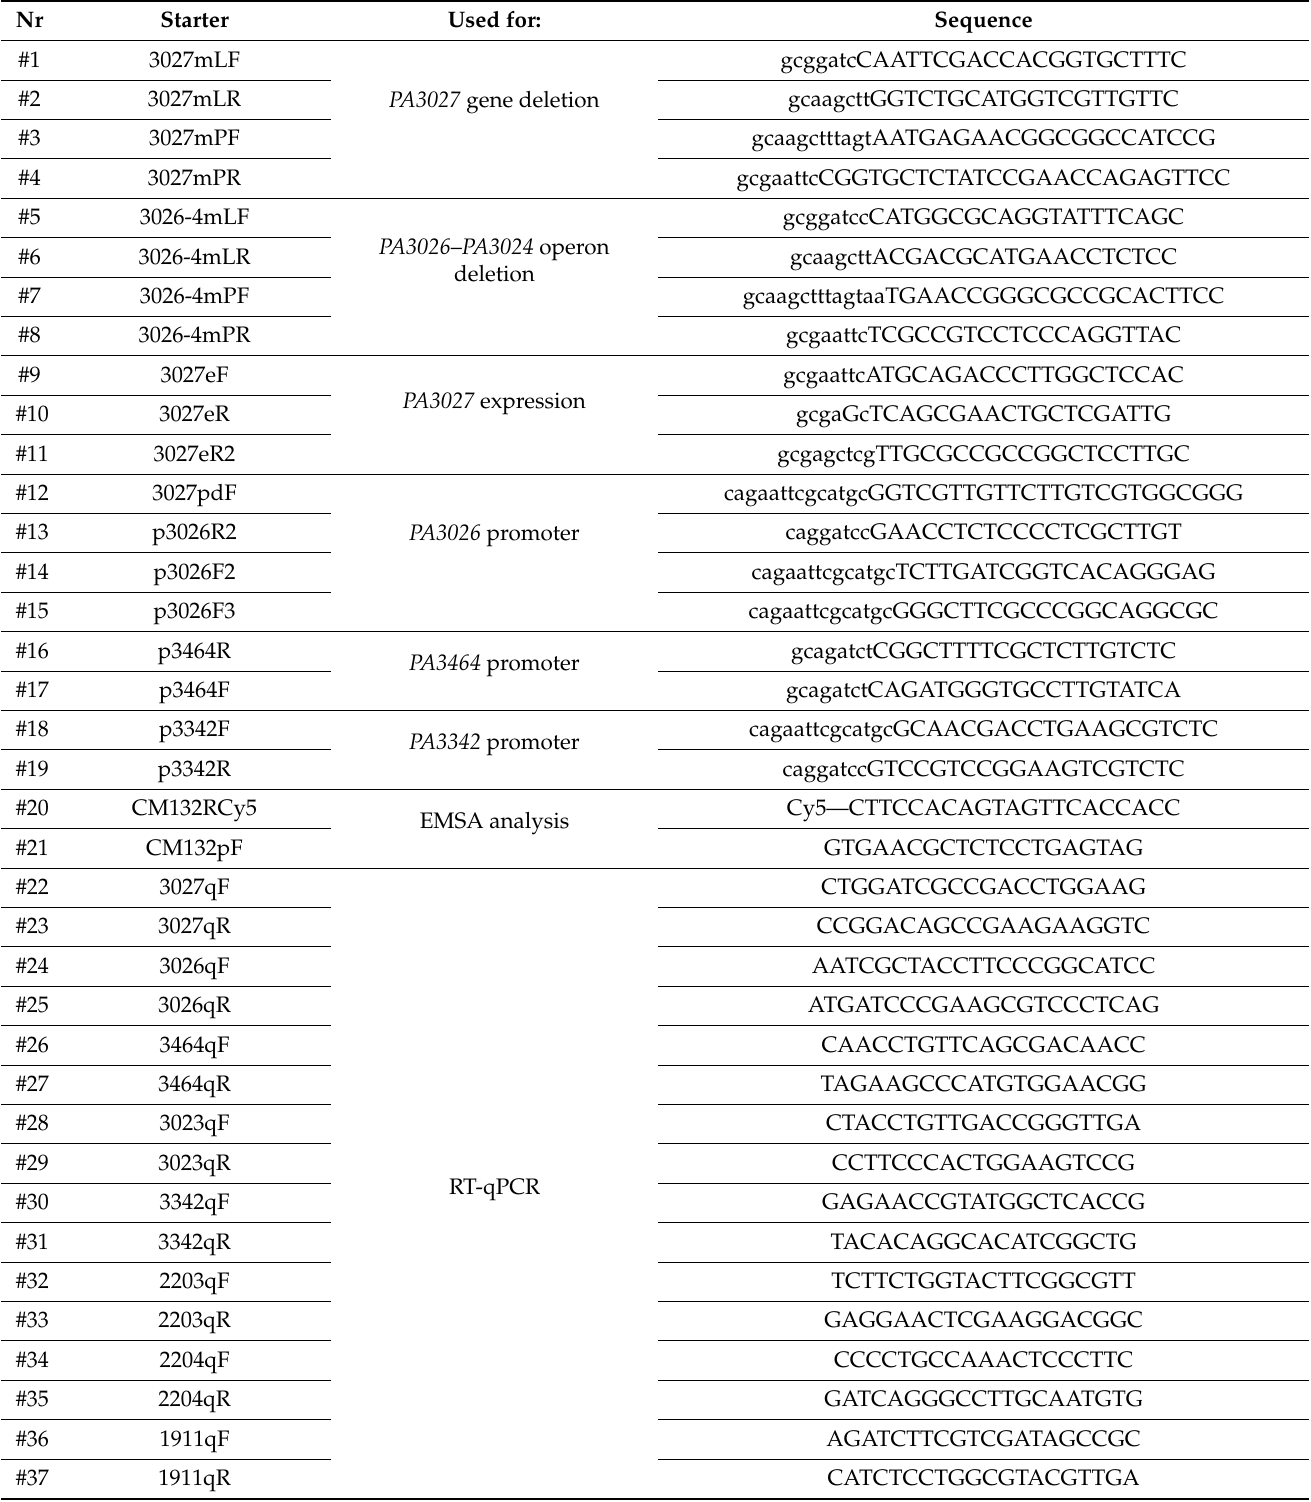
Table A3. List of primers used in this